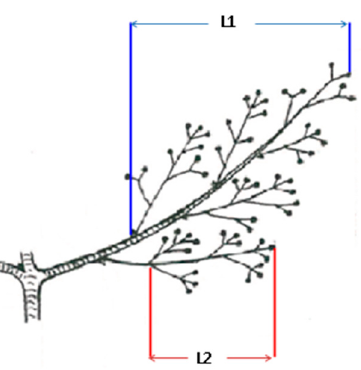
Figure 3. Grapevine inflorescence just before flowering. The two lengths ( L 1 and L 2) of the main and secondary rachis, respectively, are measured to assess the number of flowers per inflorescence.